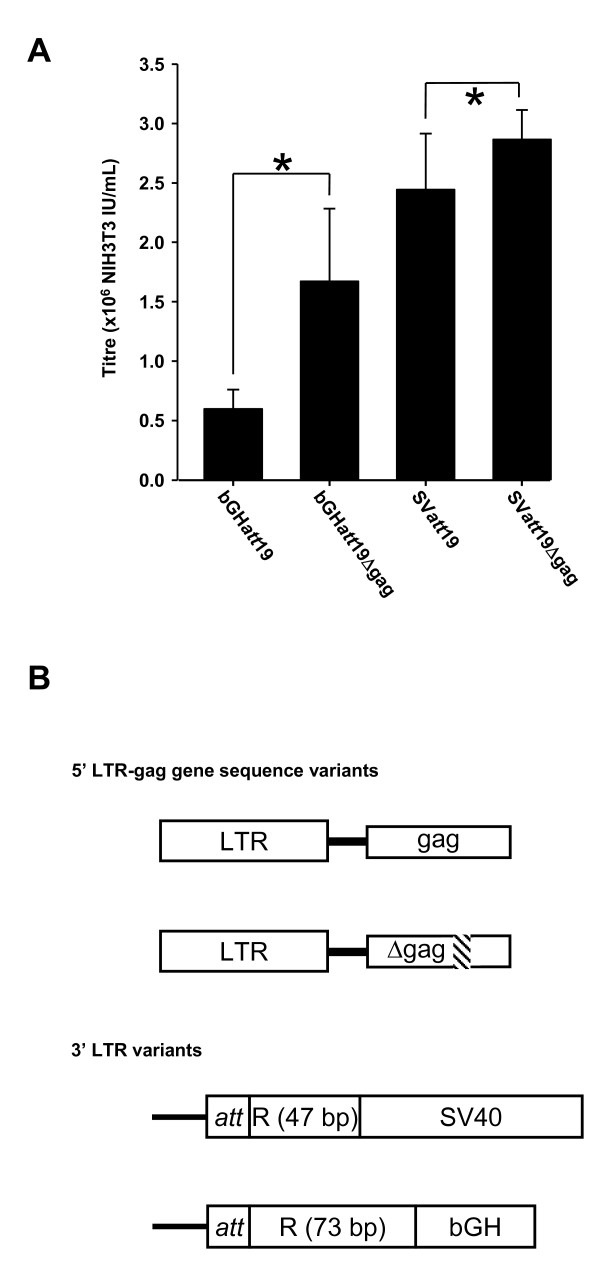
Effect of combination gag and 3'U3 modifications on virus titre. (A) Vectors containing both the Δgag and 3'U3 deletions were compared for virus titre using 0.125 ug vector per well. bGHatt19, pHIV1SDm2SEbGHatt19; bGHatt19Δgag, pHIV1SDm2SEbGHatt19Δgag; SVatt19, pHIV1SDm2SESVatt19; SVatt19Δgag, pHIV1SDm2SESVatt19Δgag (pRK1). * = P < 0.001, ANOVA with Holm-Sidak multiple comparison. All results are presented as Mean ± SD (n = 6). (B) Schematic of 5' LTR and gag gene sequence and 3' LTR variants present in the constructs tested. The region of the gag gene deleted in the "Δgag" constructs is indicated by cross hatching. All constructs contain a 19 bp att sequence in the 3' LTR and the R sequence is truncated at the 3' end.